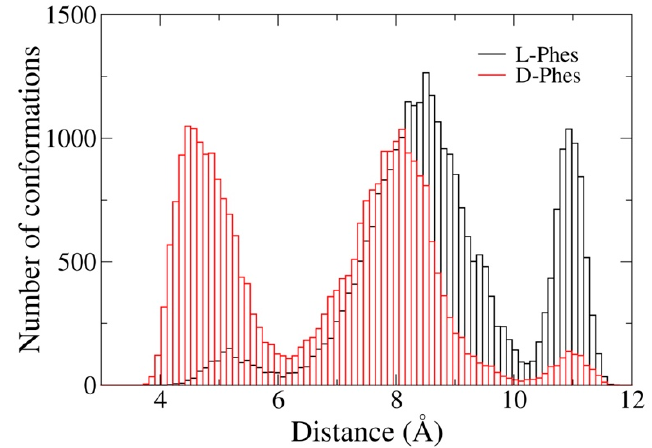
Figure 8. Distribution of the center of mass distance between second and third phenyl rings during the last 100 ns of all three runs.